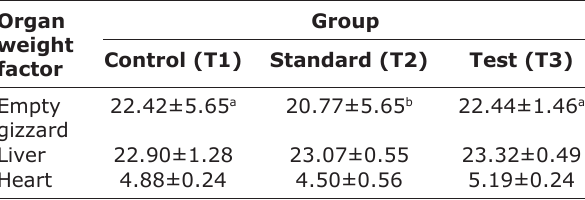
Table-5: Effect of supplementing CSE on organ weight factor in broiler birds (n=6). Organ